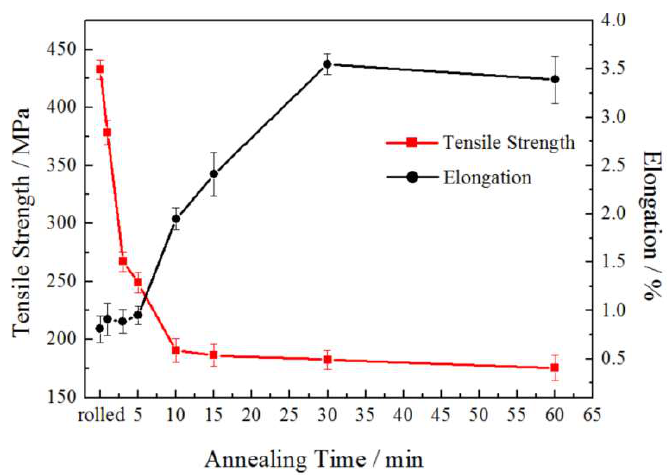
Figure 10. Effect of annealing time on tensile properties of copper